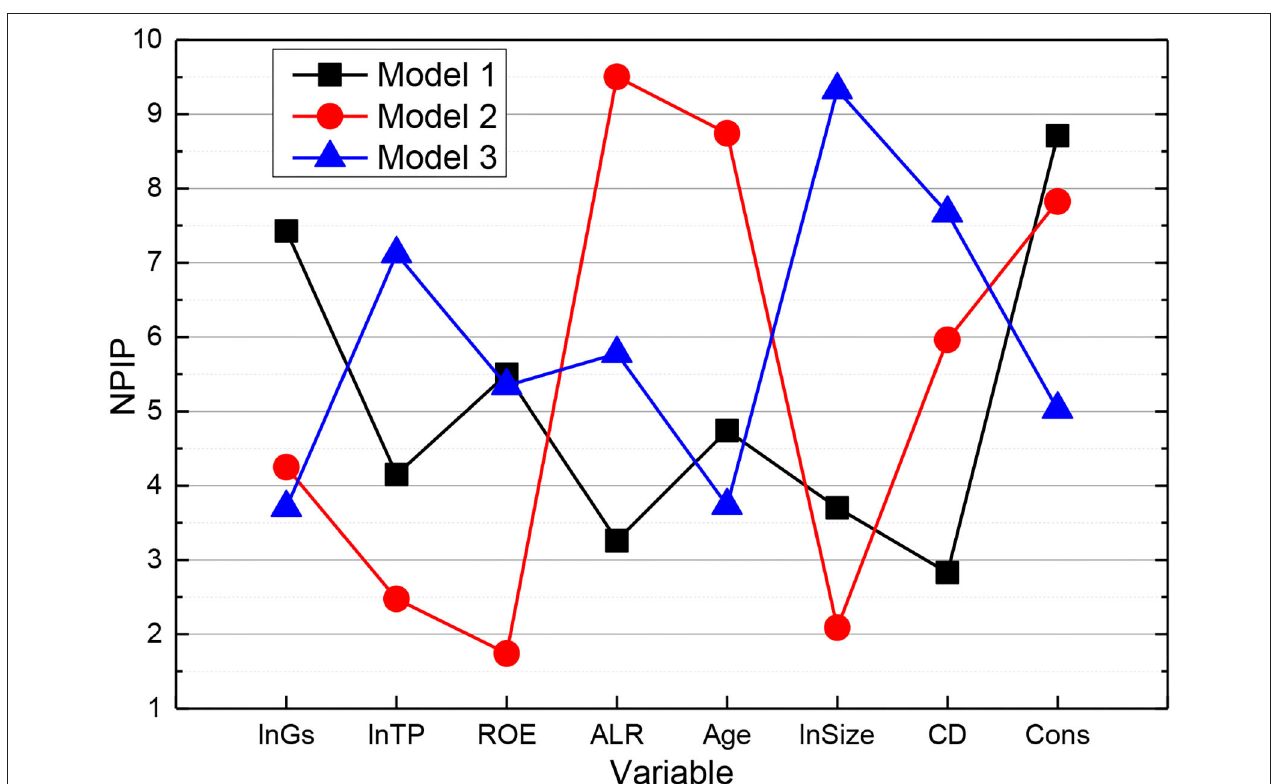
FIGURE 7 | Negative binomial regression